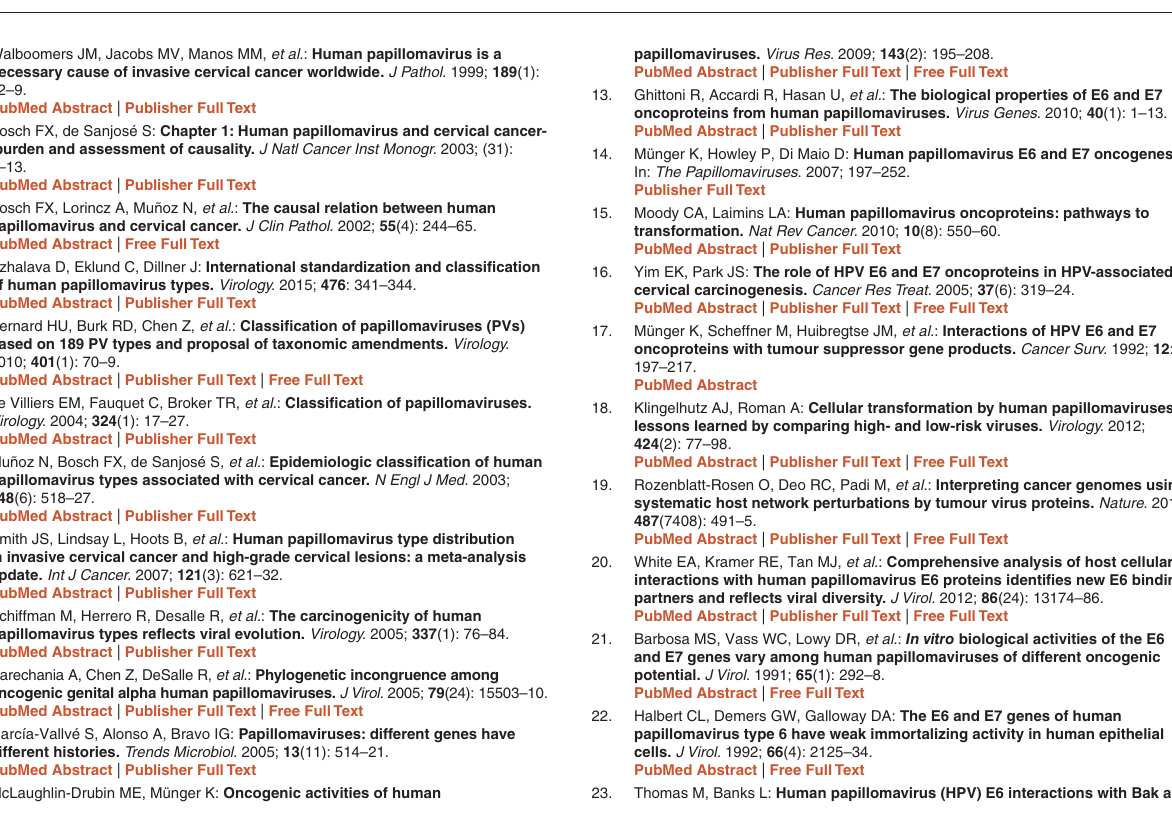
• Figure S3: Boxplots showing the distributions of the identity fraction of each nucleotide (NN) and amino acid (AA) in the genome and protein sequences of the inser- tion (not considering gaps for both NN and AA). The individual identity fractions of each position are overlaid. • Figure S4: RNA fold secondary structure prediction of HR HPV strains 16 (A), 18 (B), 45 (C) and 31 (D). The nucleotides of the first motif are marked in red, and of the second motif in purple. E7 AUG is noted in red